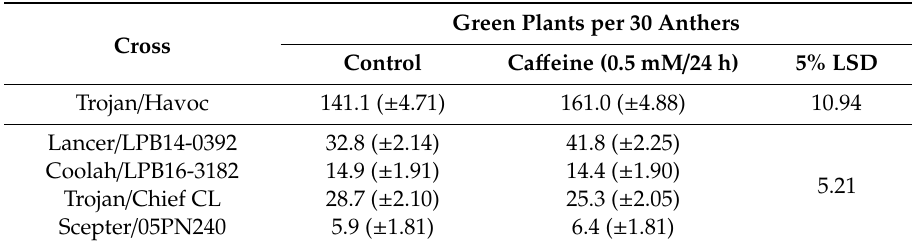
Table 2. Means ( ± SE) of green plant numbers, expressed per 30 anthers, following ca ff eine treatment during anther culture on five crosses in